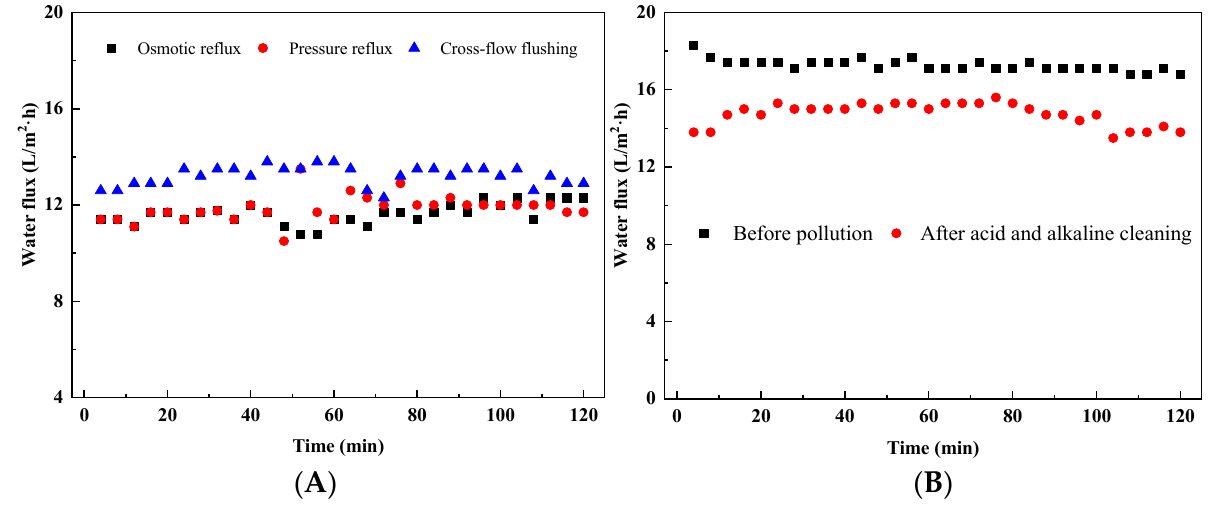
Figure 6. The effect of different physical cleaning methods on water flux ( A ), and the effect of acid and alkaline cleaning methods on water flux ( B